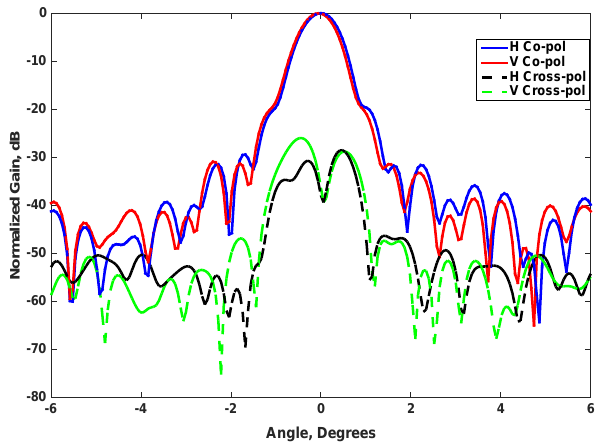
Figure 4. E-plane co- and cross-pol radiation patterns of HCR’s lens